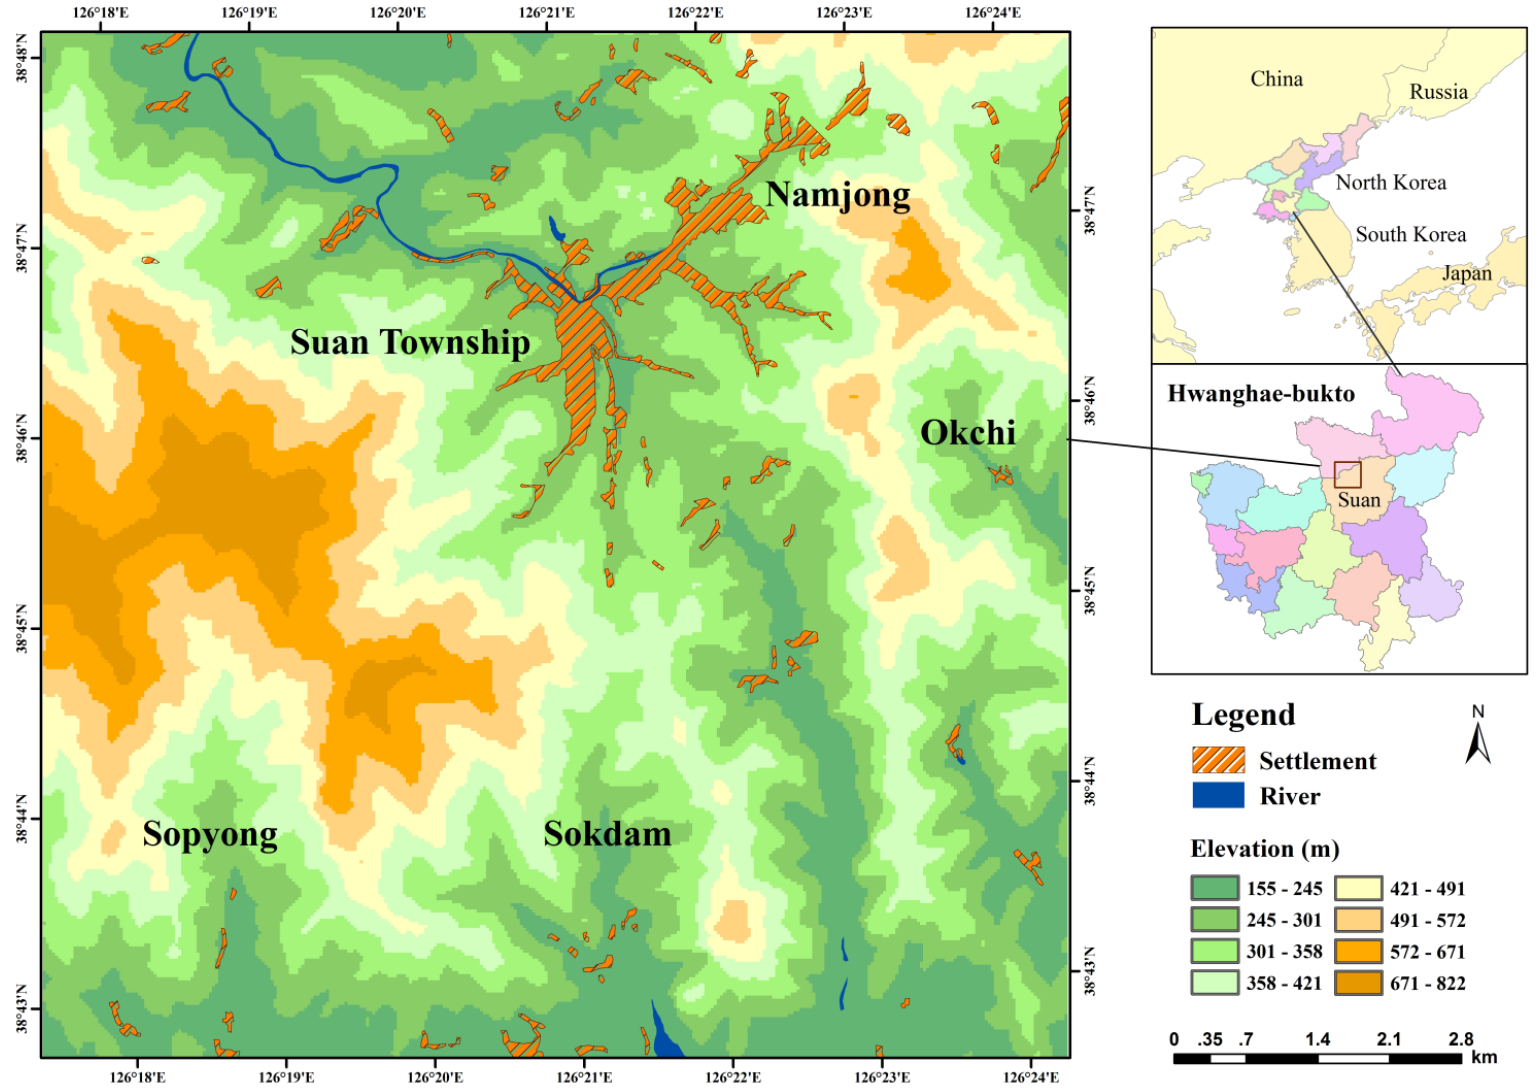
Figure 1. Location map of the study area (10 × 10 km 2